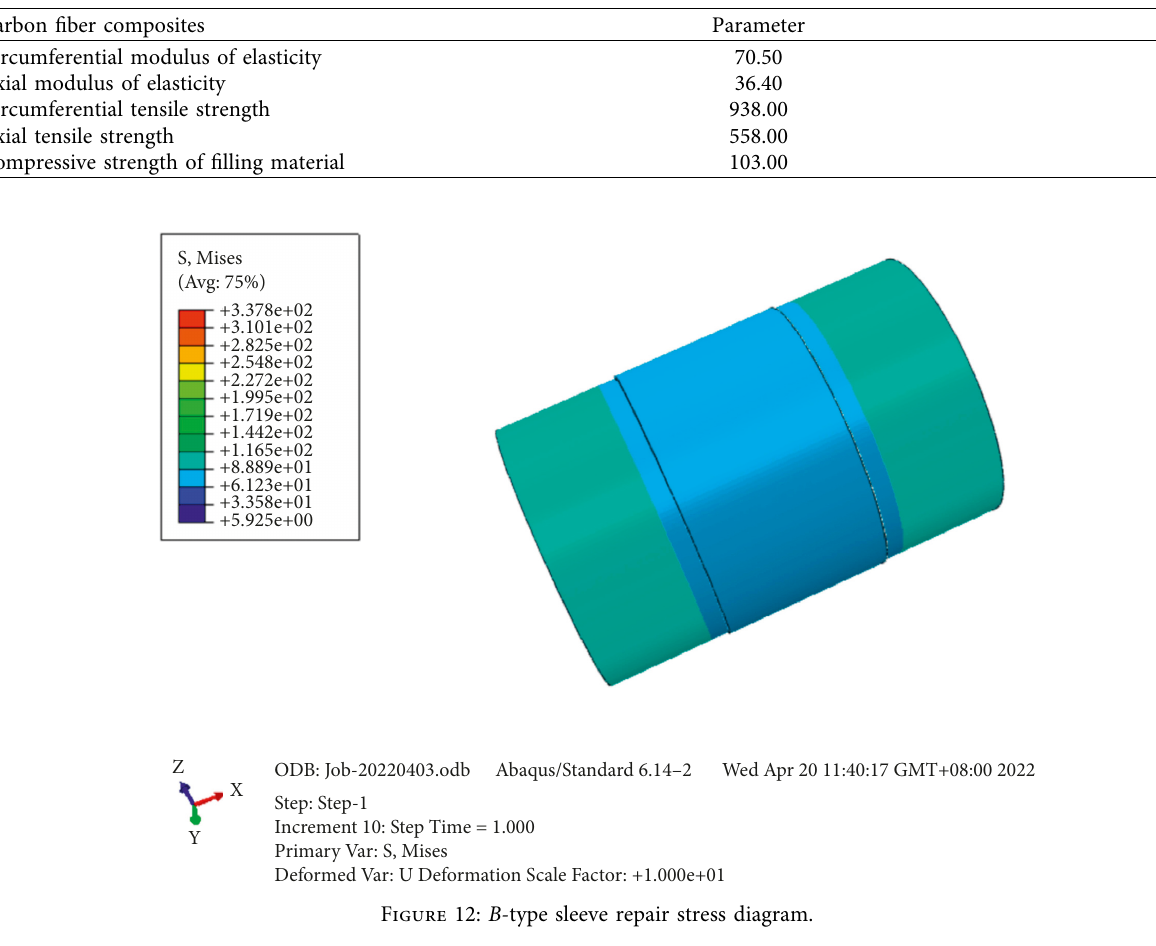
Table 1: Parameters of carbon fiber composites.